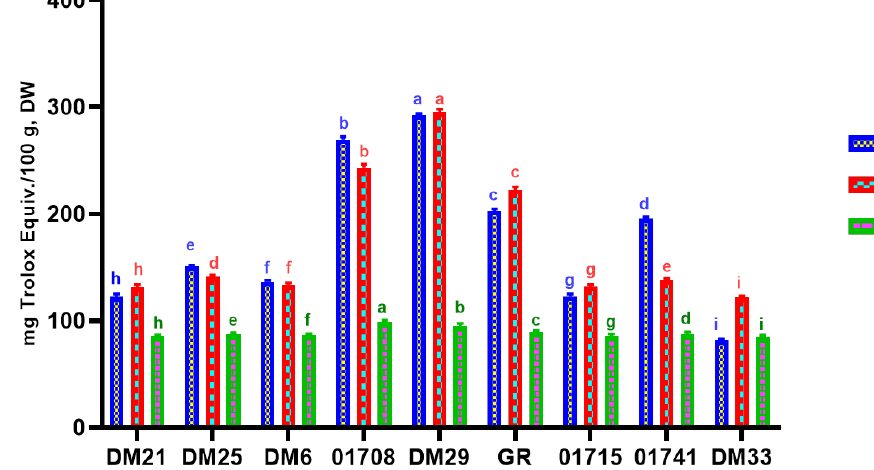
Figure 3. Antioxidant activities (DPPH, ABTS and FRAP) of nine rice varieties. Results were expressed as mean ± SD of triplicate analyses. Different alphabetical letters in each column represent statistically significant differences (Tukey and Duncan test p ≤ 0.05) DW, dry weight